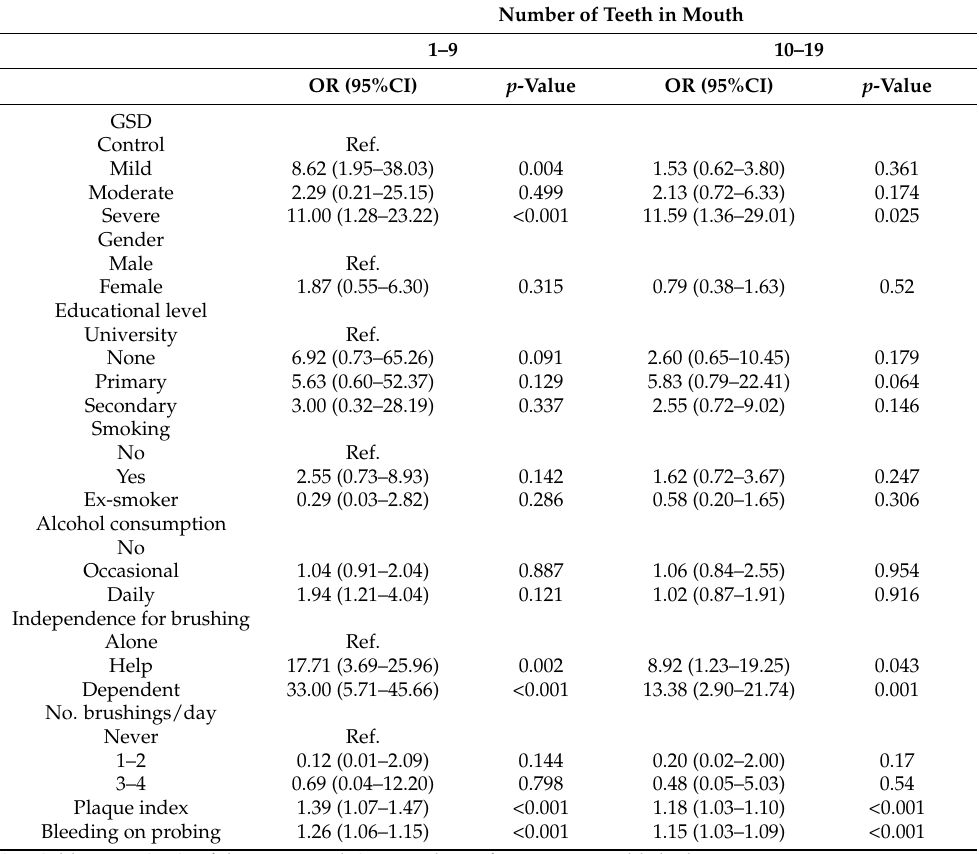
Table 4. Influence of the demographic and clinical variables upon the number of teeth.